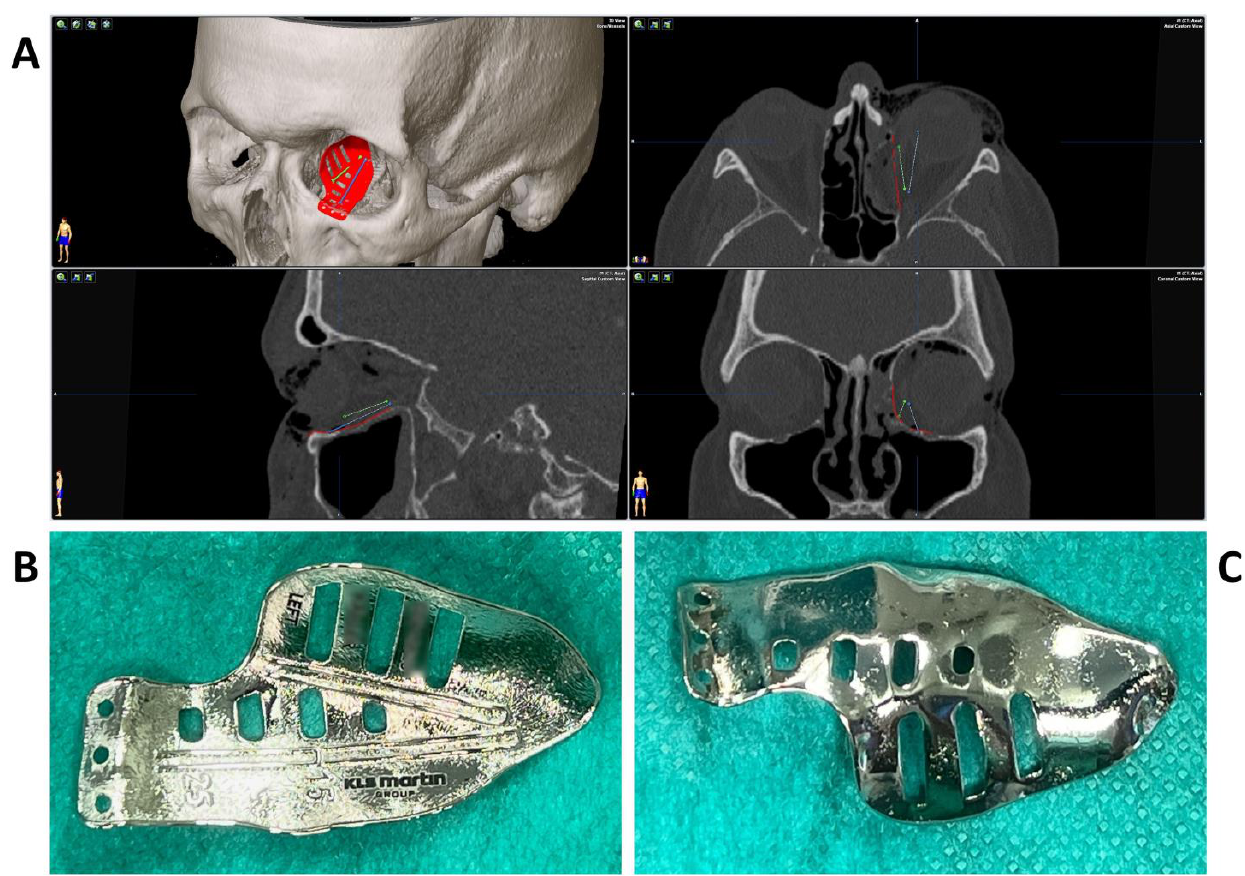
Figure 1. Clinical photographs of the patient showing an enophthalmos in the perspective from below ( A ), and above ( C ), while there is no hyper- or hypoglobe present as visible in the frontal view ( B ). Axial ( D ) and coronal ( E ) plane of the pre-operative CT scan displaying the traumatic defect of the medial wall and floor of the left orbit.